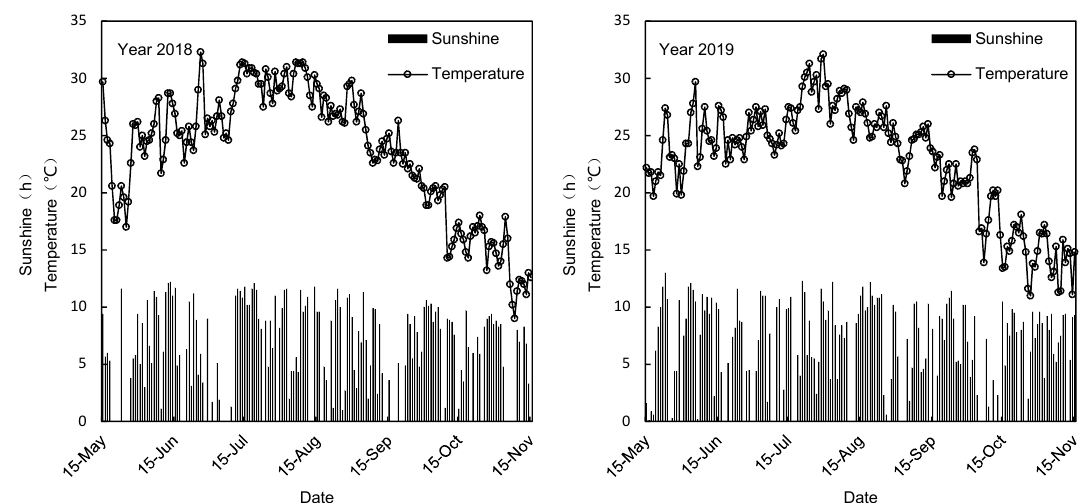
Figure 1. Average daily sunshine hours and temperature during rice growth season of 2018 and 2019 in the experimental site.